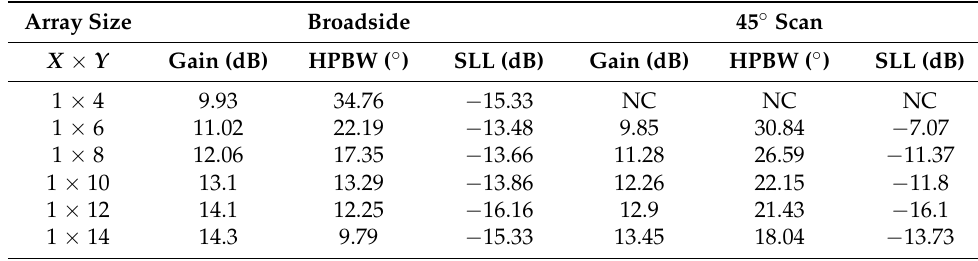
Table 2. Linear array characteristics by number of